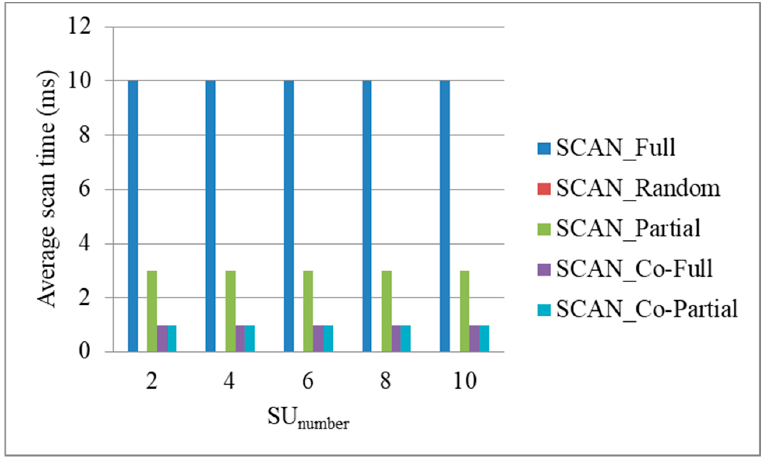
Figure 16. Average scan time under different number of SU cars (PU number = 10, P PUaccess = 0.5, V = 10).